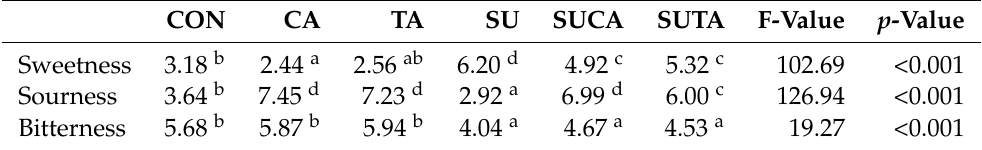
Table 5. Means and HSD letters of differences in sweetness, sourness and bitterness perception between coffee samples. F- and p -values for ANOVA model. Letters are HSD pairwise significant, and are to be read row-wise. Samples are Control (CON), Citric Acid (CA), Tartaric Acid (TA), Sucrose (SU), Sucrose, and Citric Acid (SUCA), and Sucrose and Tartaric Acid